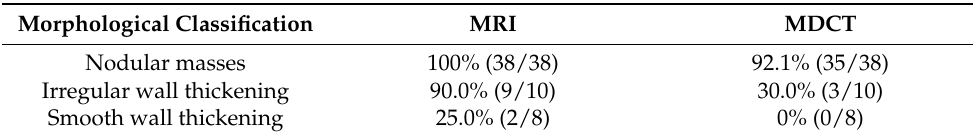
Table 4. MRI and MDCT diagnostic accuracy of different tumor morphologies in 56 patients with recurrent